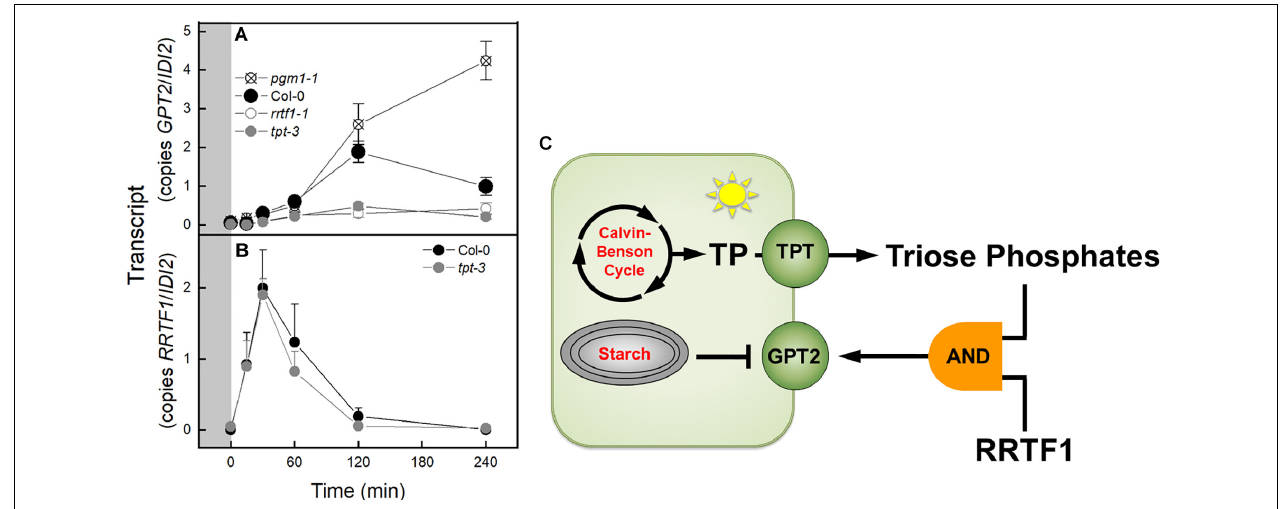
FIGURE 7 | Expression of GPT2 and RRTF1 in response to an increase in PFD from 120 to 500 µ mol m − 2 s − 1 C a 400 ppm in Col-0 and mutants and model of transcriptional regulation of GPT2 . (A) qPCR data of expression of GPT2 in Col-0 and pgm1-1 , rrtf1-1 , and tpt-3 mutants. n = 5 (B) qPCR data of expression of RRTF1 in Col-0 and tpt-3 mutant. n = 5 (C) Model of transcriptional regulation of GPT2 expression. Triose phosphates in the cytosol and RRTF1 are both required for expression of GPT2 (shown as an “AND” logic gate) while starch synthesis represses GPT2